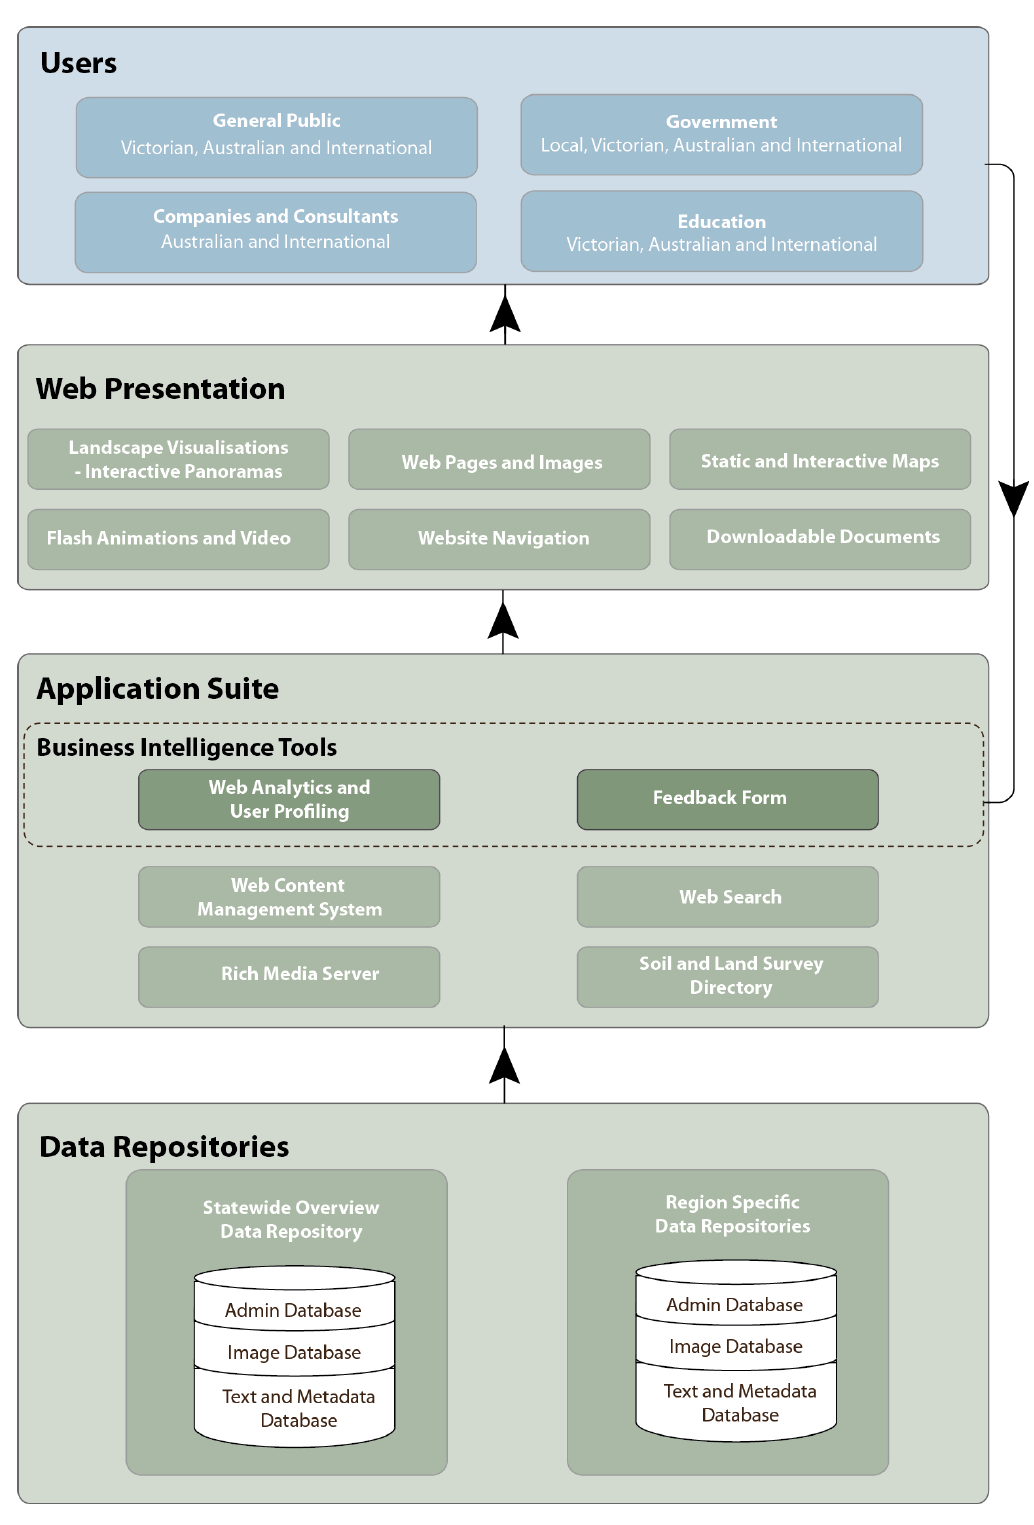
Figure 2. Schematic diagram depicting the Victorian Resources Online (VRO) Website